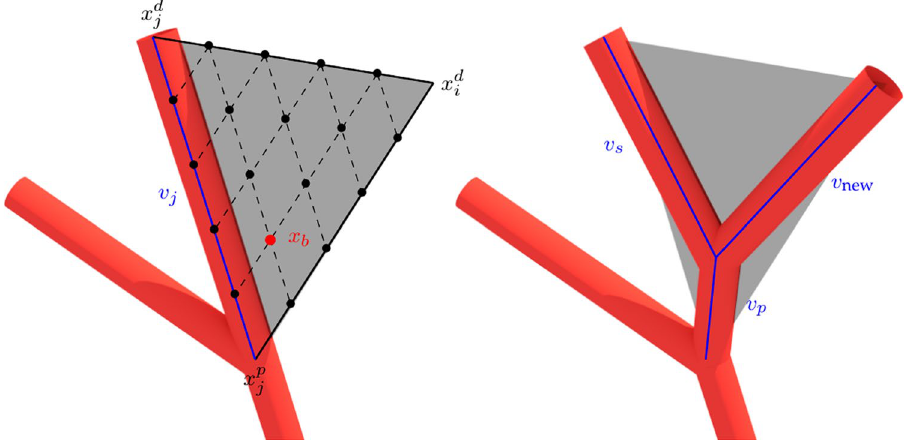
Figure 1. Bifurcation optimisation strategy for (cid:31) v = 6 : (left) discretised domain to look for the optimal bifurcation point x b between vessel v j and the candidate terminal point x d i ; (right) new tree structure for optimal bifurcation point x b replacing vessel v j by vessels v p , v s and v new in T . All black dots in the left image denote the set of potential bifurcation points. Images generated with Blender v2.8 available at https ://www.blend